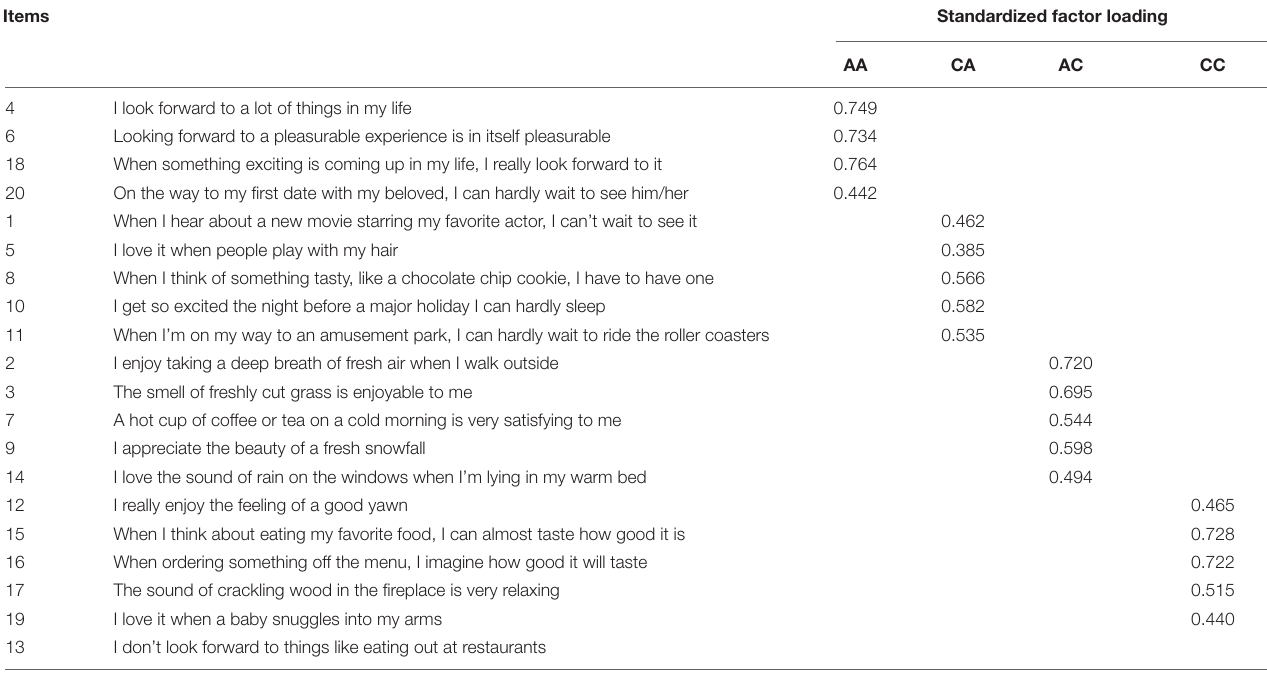
TABLE 5 | Factor loadings of the 4-factor solution for the TEPS in the Chinese sample. Items